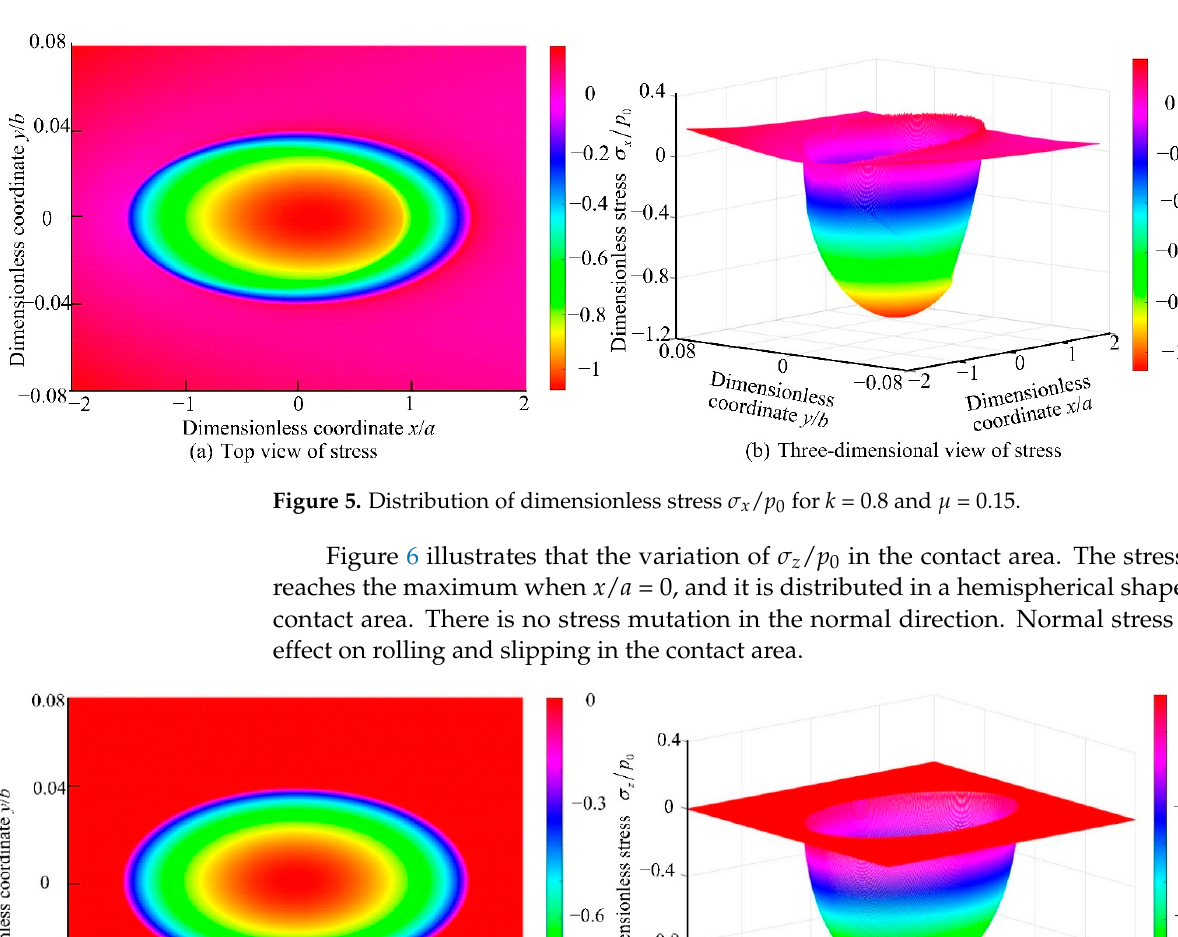
Figure 5. Distribution of dimensionless stress σ x / p 0 for k = 0.8 and µ = 0.15.